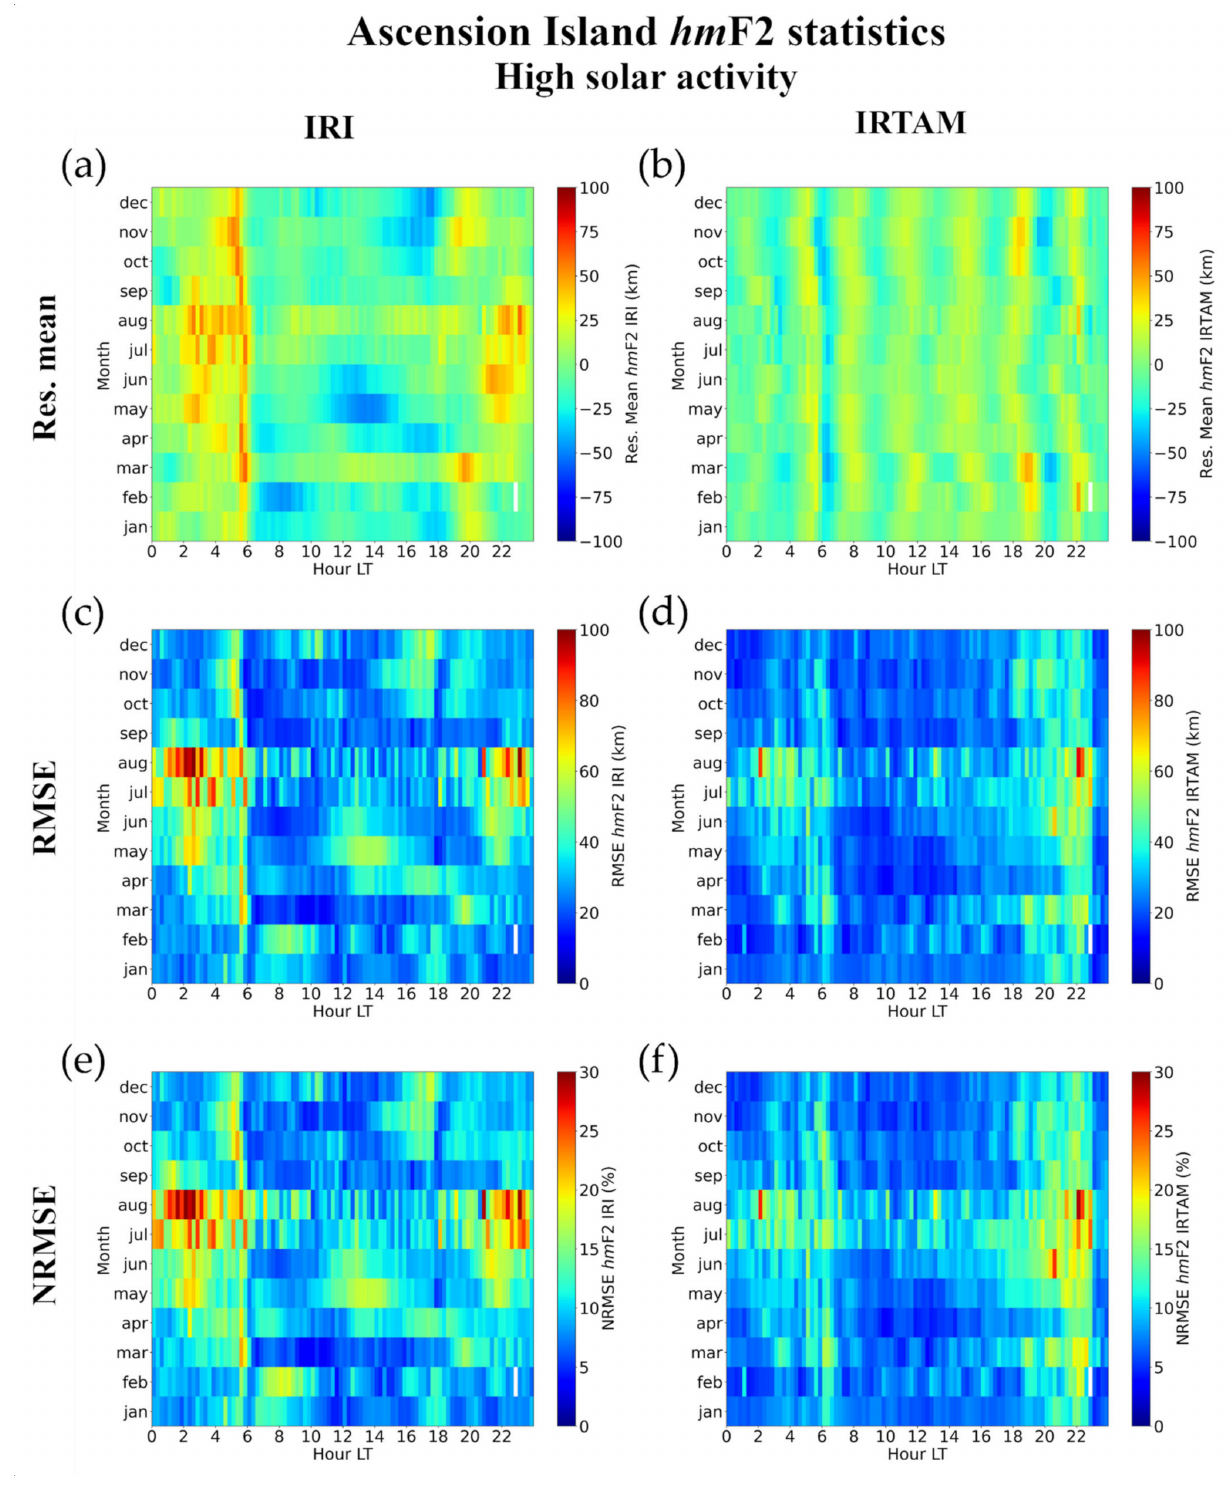
Figure 30. Same as Figure 28 but for HSA